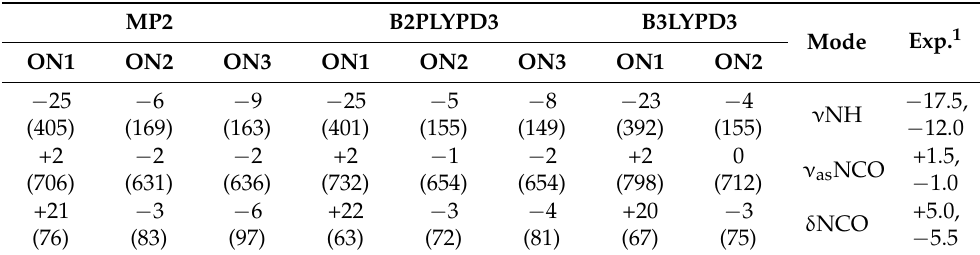
Table 5. Selected wavenumber shifts (cm − 1 ) calculated for the 1:1 complexes using the MP2, B2PLYPD3 and B3LYPD3 methods with the 6-311++G(3df,3pd) basis set compared to the